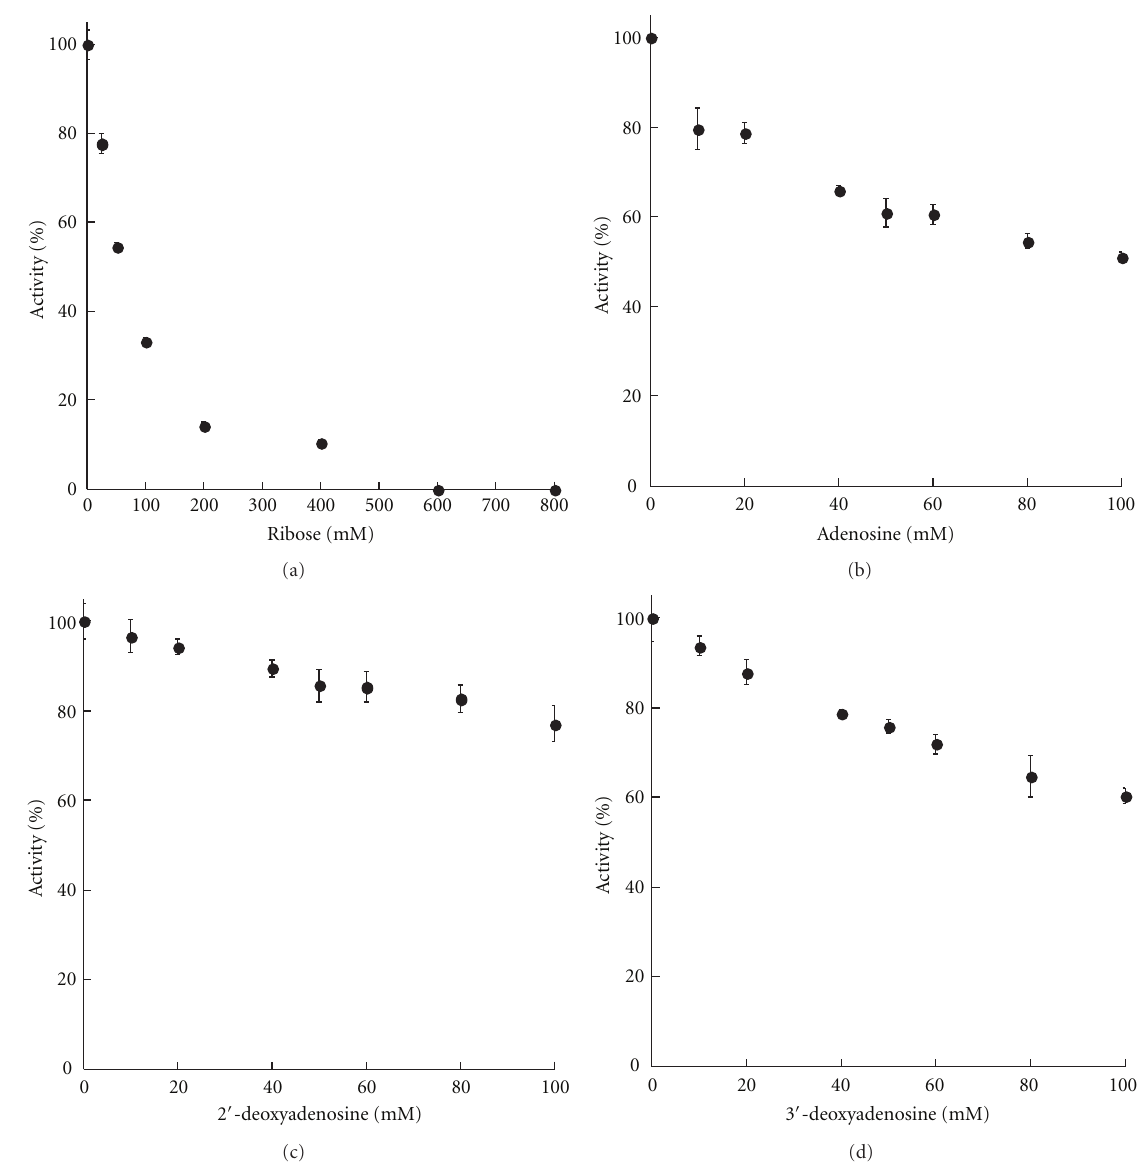
Figure 2: Inhibition of Acs1 Mt . (a) Ribose, (b) adenosine, (c) 2 (cid:2) -deoxyadenosine, and (d) 3 (cid:2) -deoxyadenosine. Assays were performed with the indicated concentrations of inhibitor in the reaction, and results are plotted as a percentage of the activity observed in the absence of inhibitor, with error bars as shown. The K i value for each inhibitor was determined by extrapolation of the